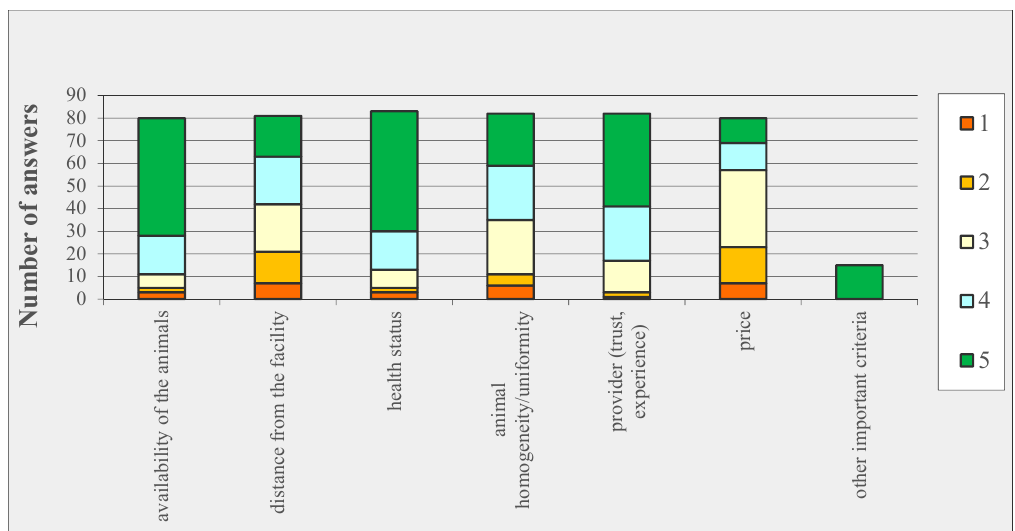
Figure 2. Main criteria for choosing a sheep supplier (several options were possible, rated from 5 (very important) to 1 (not important)).